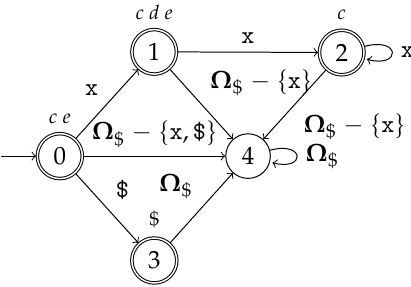
“ M c | M d | M e | M $ for the specification Ξ in $